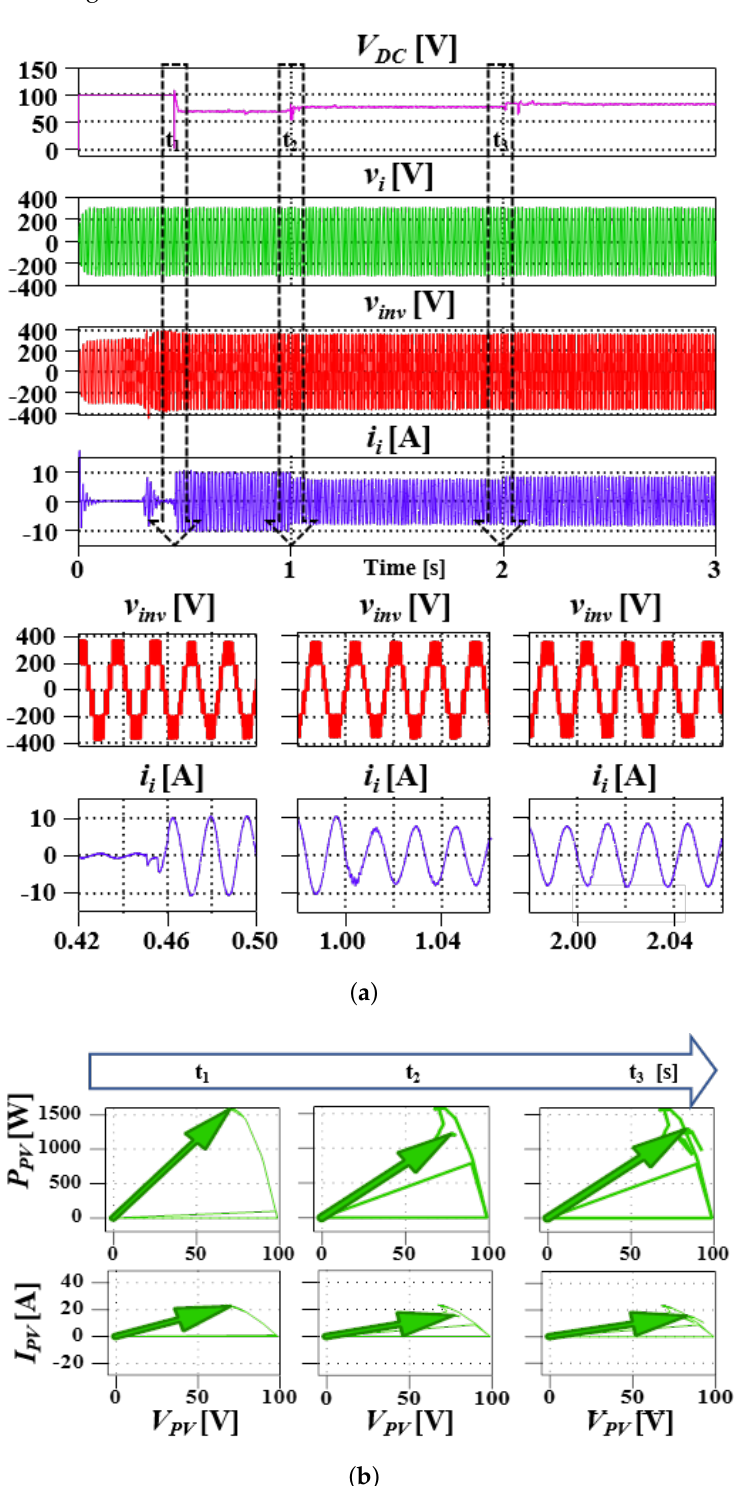
Figure 9. System’s DC (PV) grid voltage, current and converter AC output voltage in response to various change in PV conditions ( a ), and the PV P ∼ V and I ∼ V characteristics curve demonstrating the converters response to change in weather conditions ( b